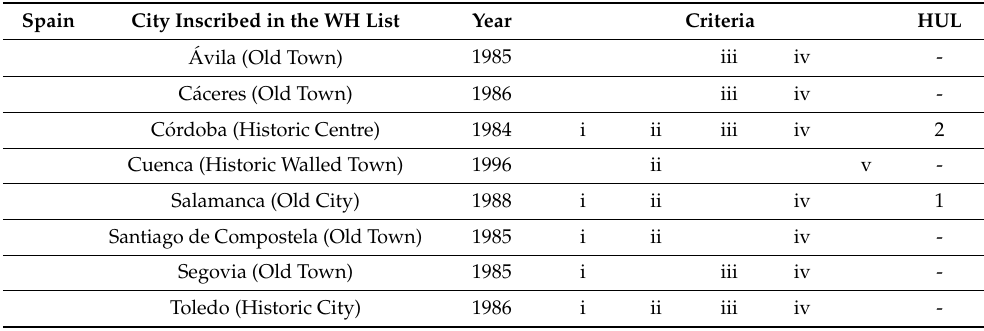
Table 2. Spanish WH cities and towns. Criteria of inscription and HUL implementation. Source: Adapted from whc.unesco.org and Pereira